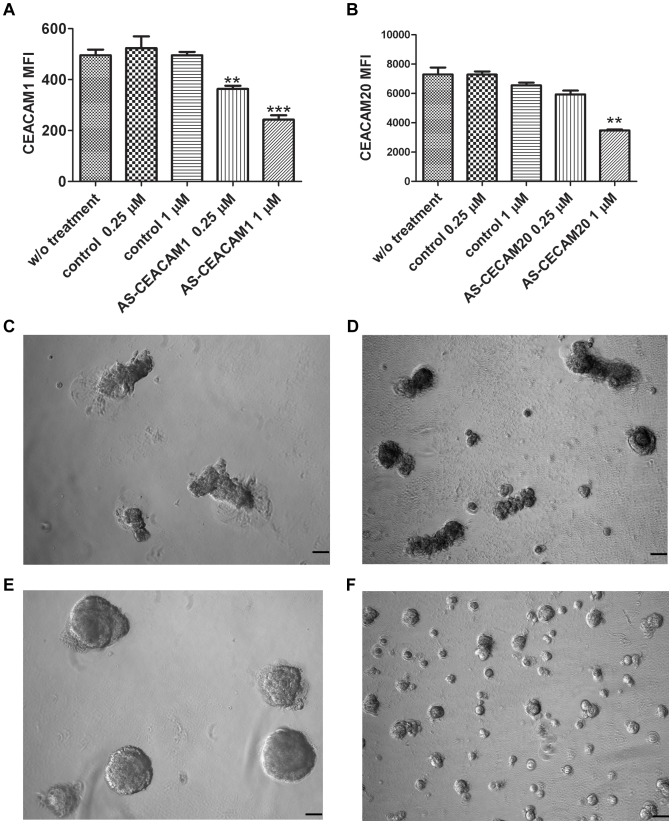
Inhibition of tubule formation with antisense oligonucleotides to CEACAM1 or CEACAM20.Efficiency of knockdown of CEACAM1 (A) or CEACAM20 (B) with antisense oligonucleotides administered by gymnosis and quantitated by measuring mean fluorescence intensity (MFI). Morphology of organoids after no treatment (C) or treatment with scramble control antisense (D) or antisense to CEACAM1 (E) or antisense to CEACAM20 (F), scale bar 100 µm.